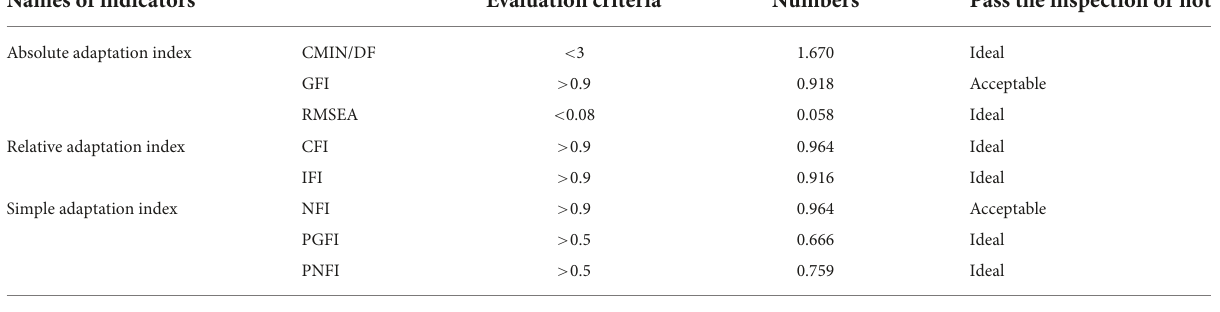
TABLE 2 Fit test form of the model.